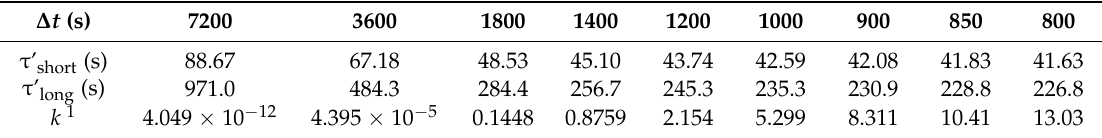
Table 2. Equivalent time constant estimation results with different values of ∆ t